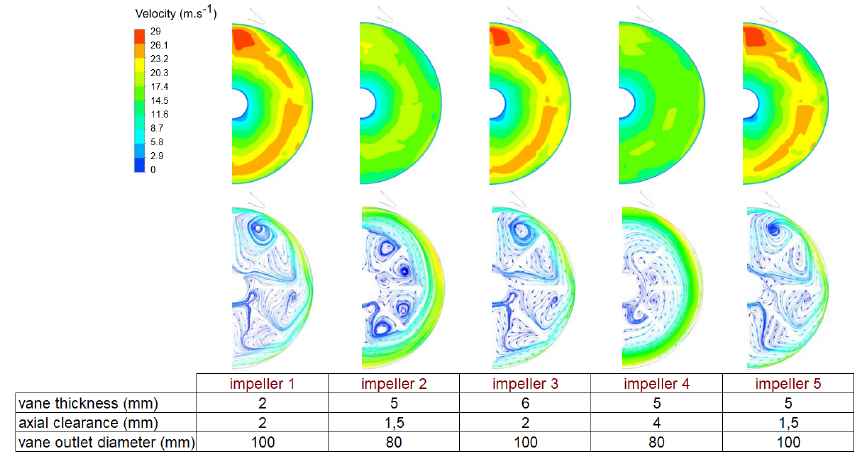
Figure 21. Difference in flow field in sidewall gaps for various geometry of back vanes. Reproduced from [129],